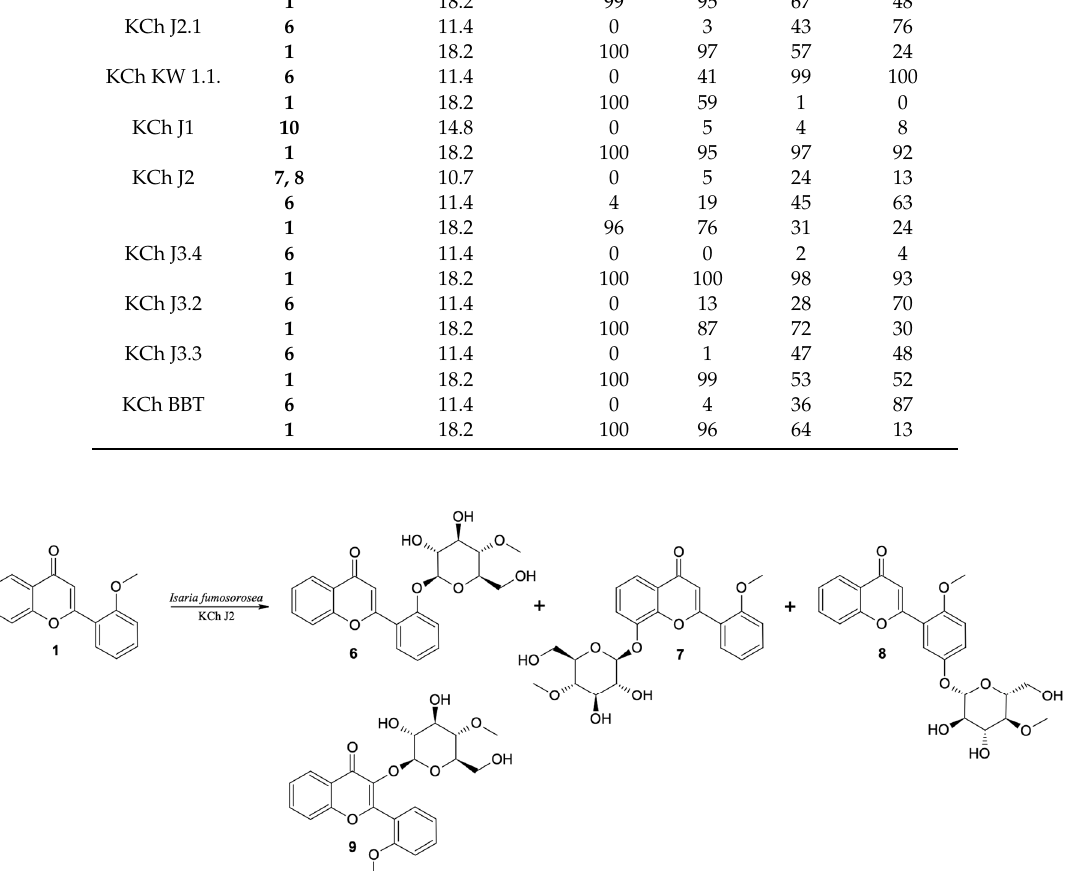
Table 1. Microbial transformation of 2 (cid:48) -methoxyflavone, HPLC conversion. Conversion after 1, 3, 7 and 10 Days [%] Retention Time Strain No. Substance [min] 1